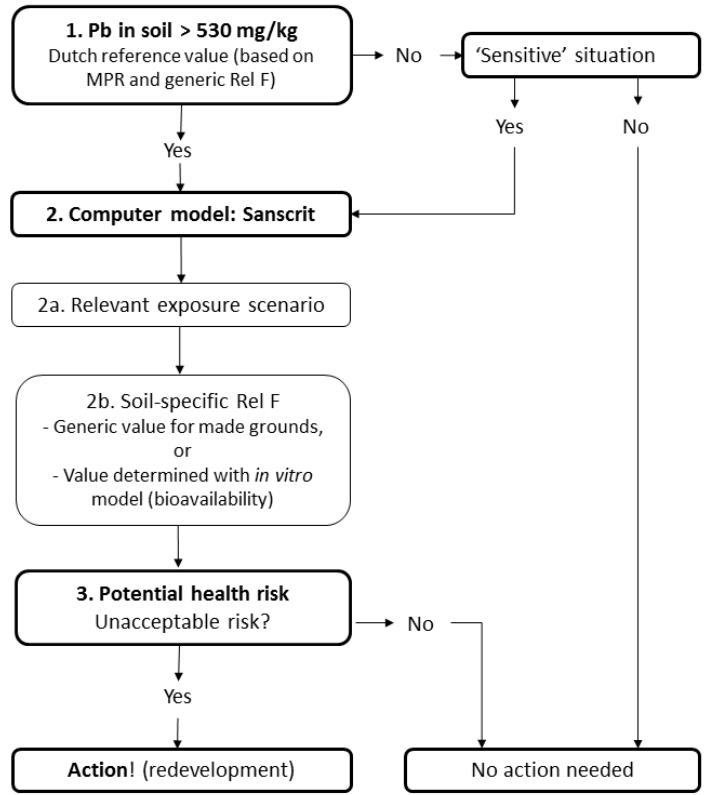
Figure 6. Current practice of risk assessment of Pb in The Netherlands (source: Van Kesteren et al. [66]; with permission).